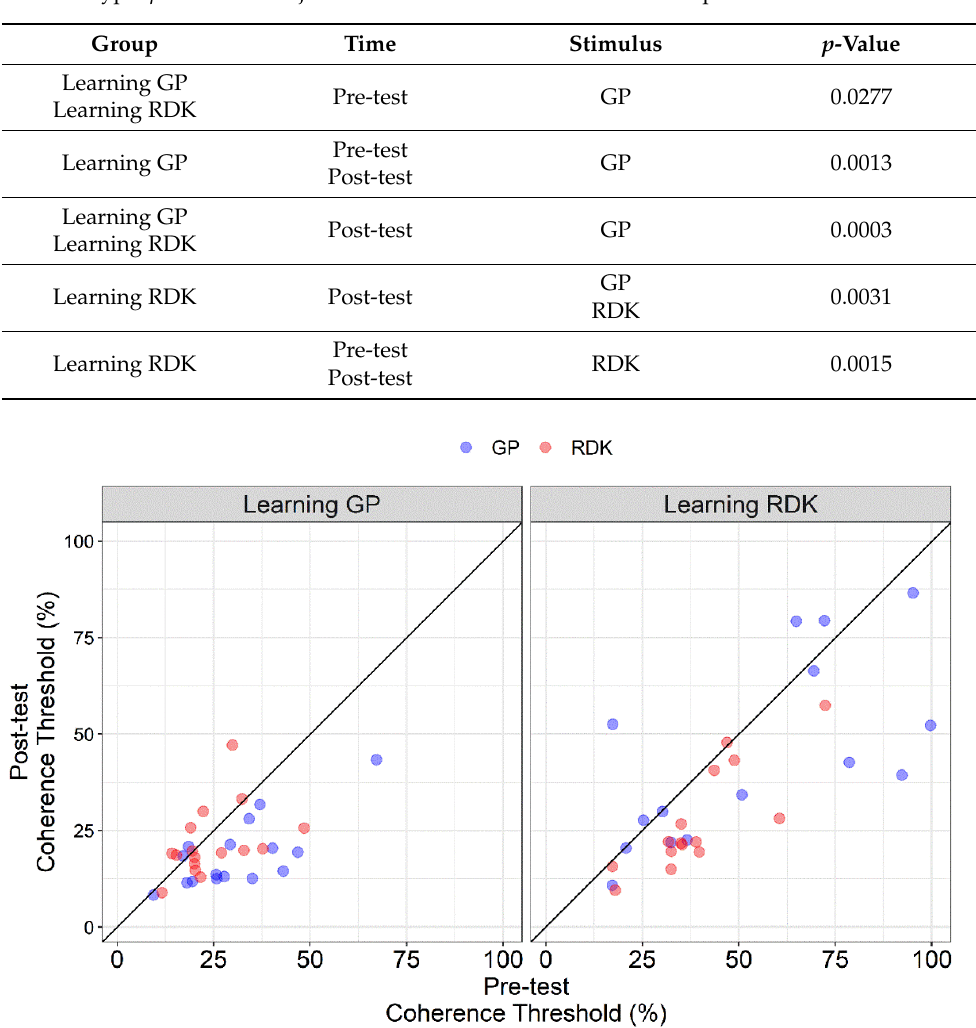
Table 3. Selected post hoc comparisons for the three-way interaction between group, time, and stimulus type. p -values are adjusted with the Holm method for 28 comparisons.